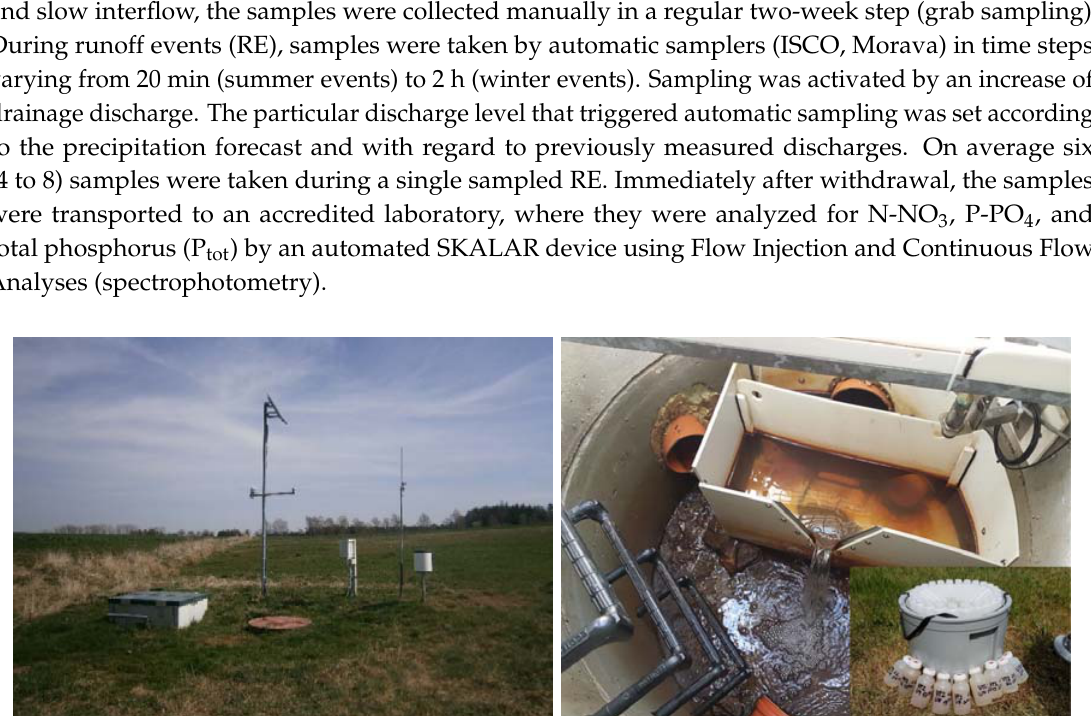
Figure 3. Using the semi-automated algorithm for the identification of REs; an example from the VP2 site. 2.3. Description of Applied Load Assessment Methods For the load assessment of N-NO 3 , P-PO 4 , and P tot , six different methods (M1 to M6) using annual (a) and/or monthly (m) time scales were employed and compared. M1 to M3 are commonly used techniques when 14 to 30 day grab sampling schemes are followed. The descriptions and equations of these methods are given